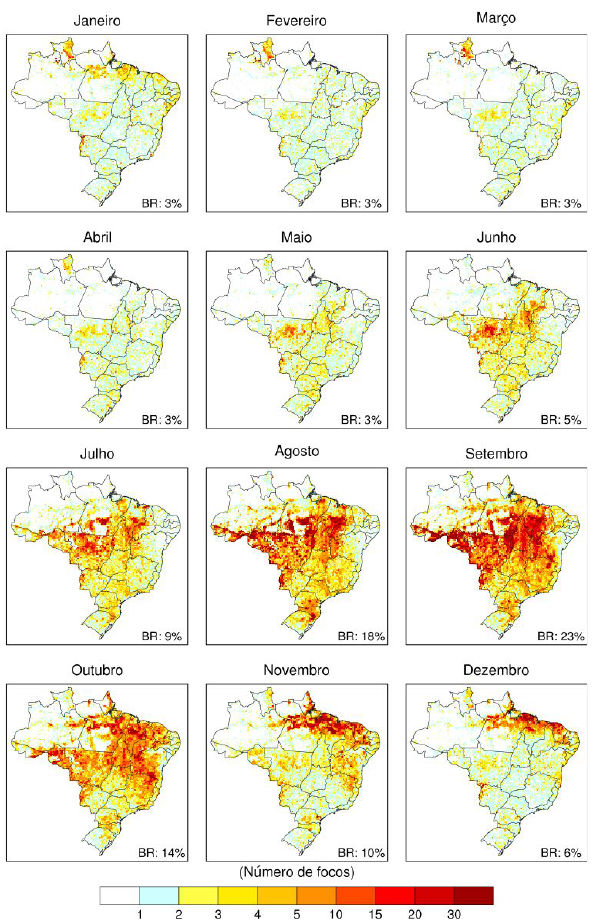
Figure 1. Appendix. Spatial distribution of monthly average active fires in Brazil from 2015 to 2018, detected by the AQUA-MODIS satellite. A percentage in the bottom right represents the monthly contribution to active